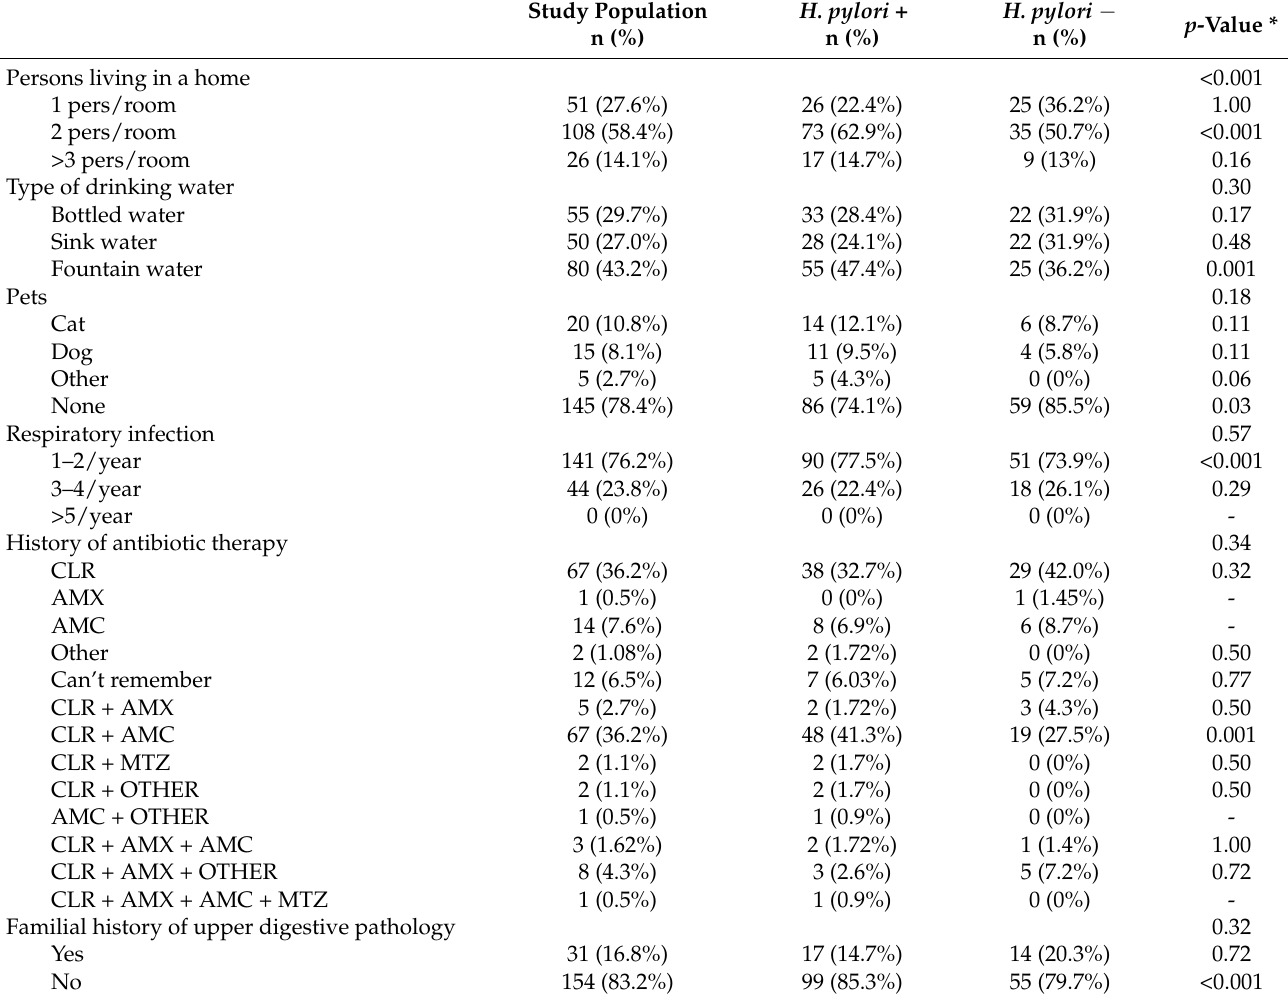
Table 2. Risk factors associated with H. pylori infection. Study